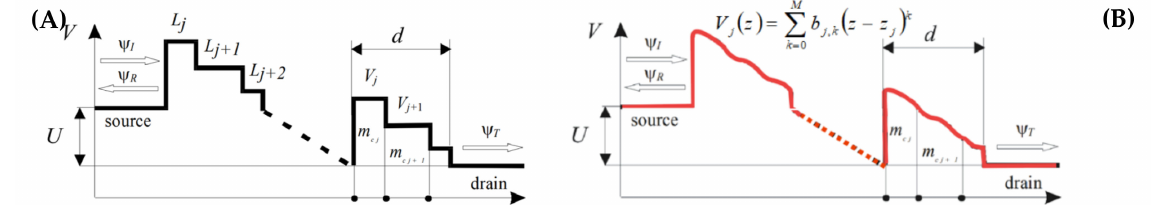
Figure 2. Concepts of approximation of the potential in the SL: ( A ) constant potential in each sub-layer of the SL, ( B ) polynomial approximation of the potential in whole